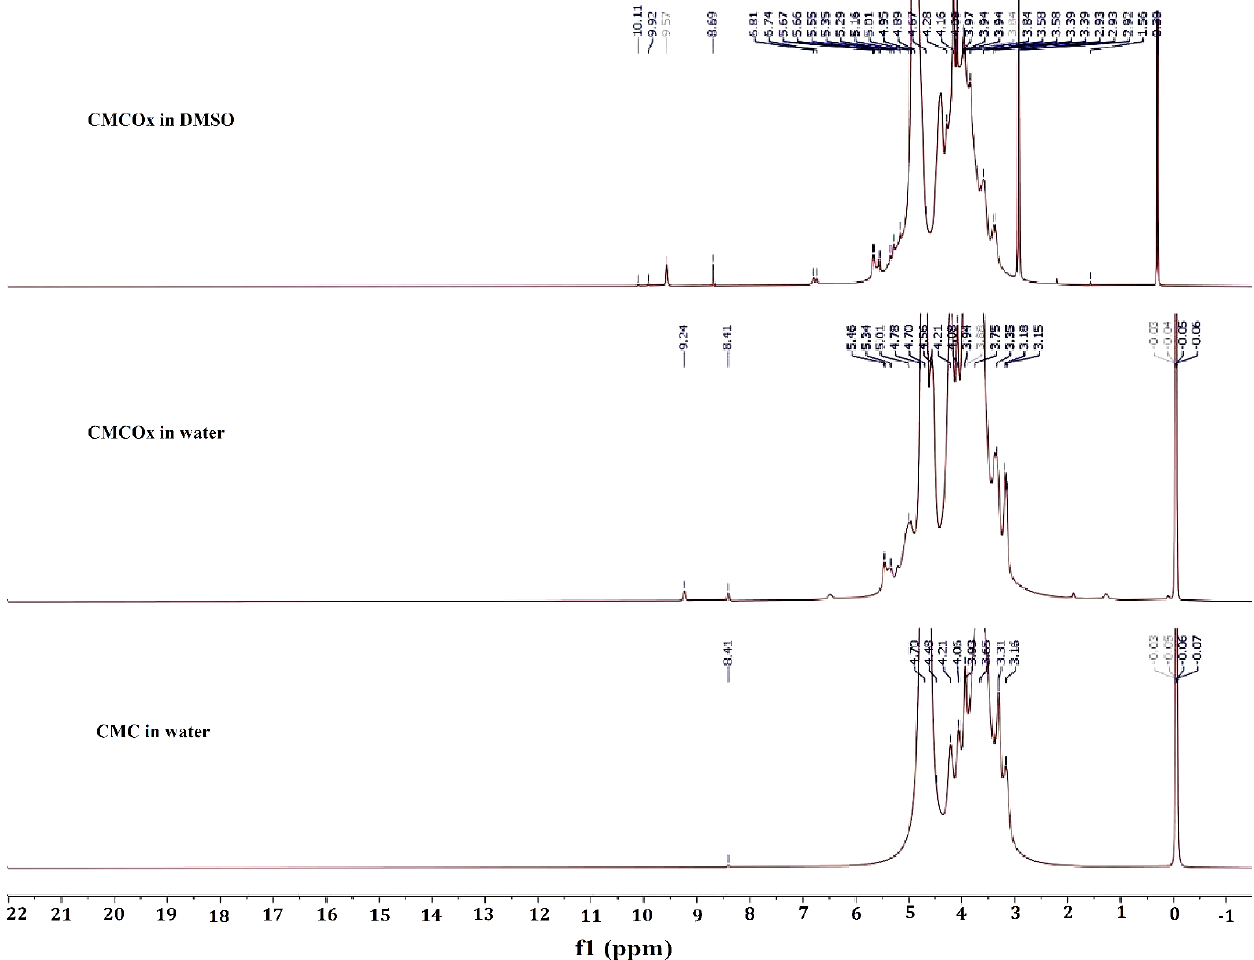
Figure 2. Proton nuclear magnetic resonance ( 1 H NMR) spectra for CMC dissolved in water, CMCOx dissolved in water, and CMCOx dissolved in DMSO.